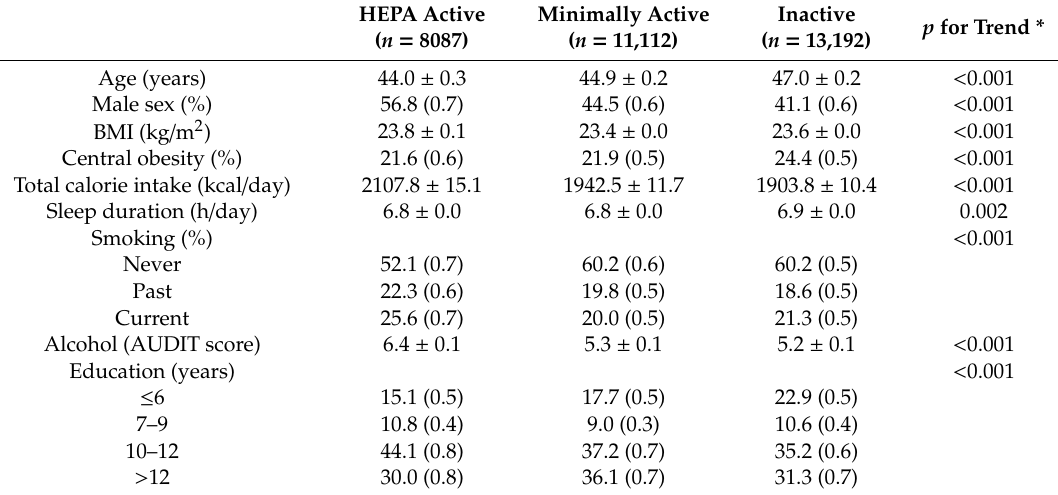
Table 1. Characteristics of participants by physical activity level ( n =